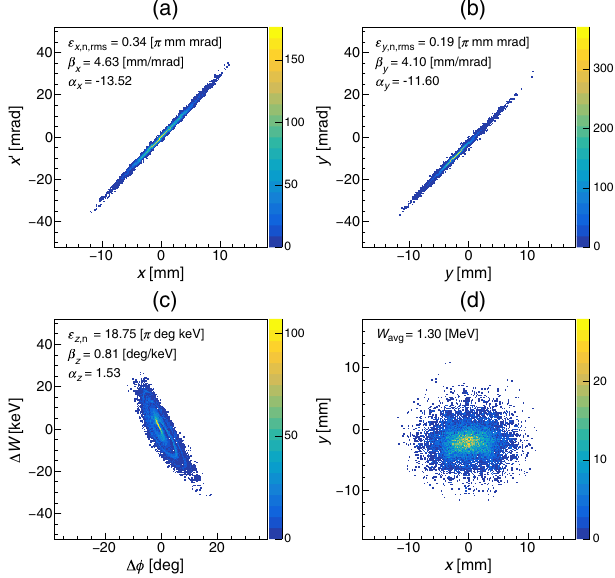
FIG. 5. Calculated phase-space distributions at the short-IH exit. (a) the horizontal divergence angle x 0 vs x , (b) the vertical divergence angle y 0 vs y , (c) energy spread Δ W ð W − 1 . 3 MeV Þ vs phase spread Δ ϕ , and (d) y vs x .